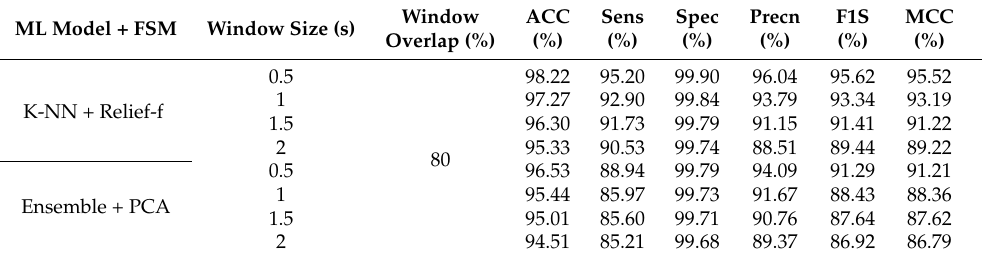
Table 11. Window size comparative study results for the K-NN best optimized model with the Relief-F feature selection